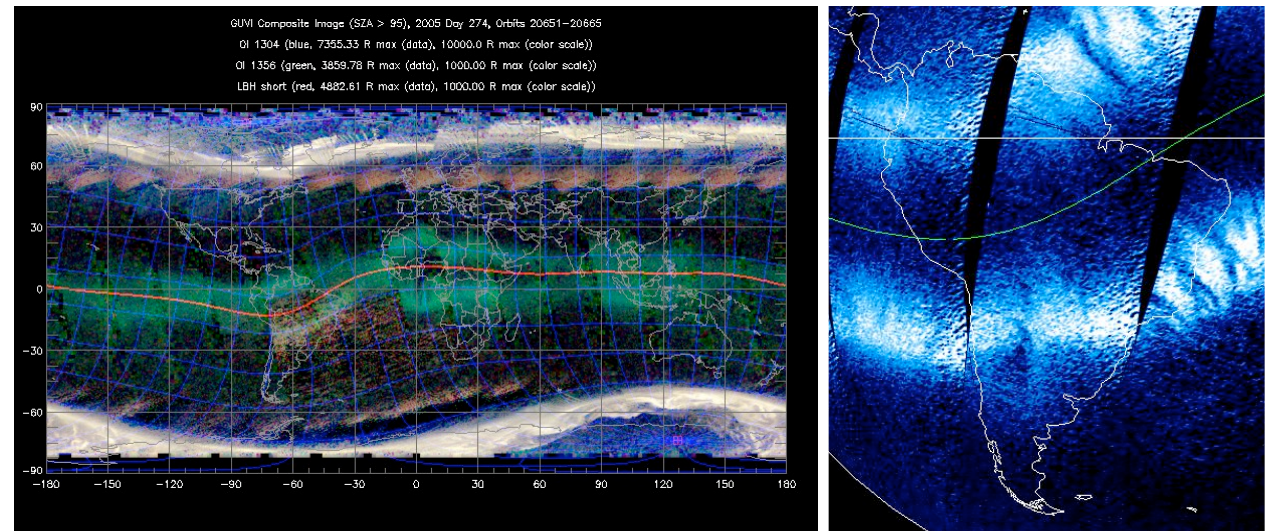
Fig. 9. Global TIMED/GUVI 1356 ˚A emissions (green) on successive orbits (left) on day 274 (1 October) 2005 during the first SpreadFEx measurement campaign and a closer view (right) over South America exhibiting plasma depletions in 1356 ˚A